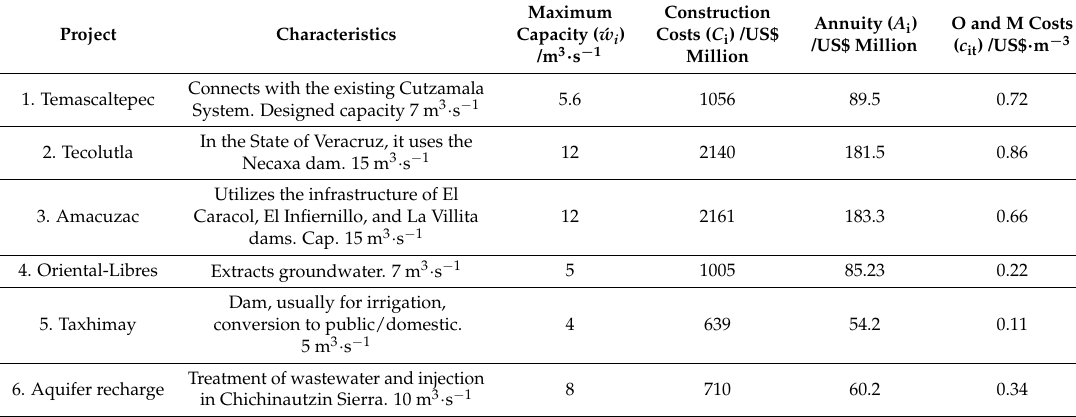
Table 5. Costs, volume capacity, and characteristics of six alternative options for water supply for Central